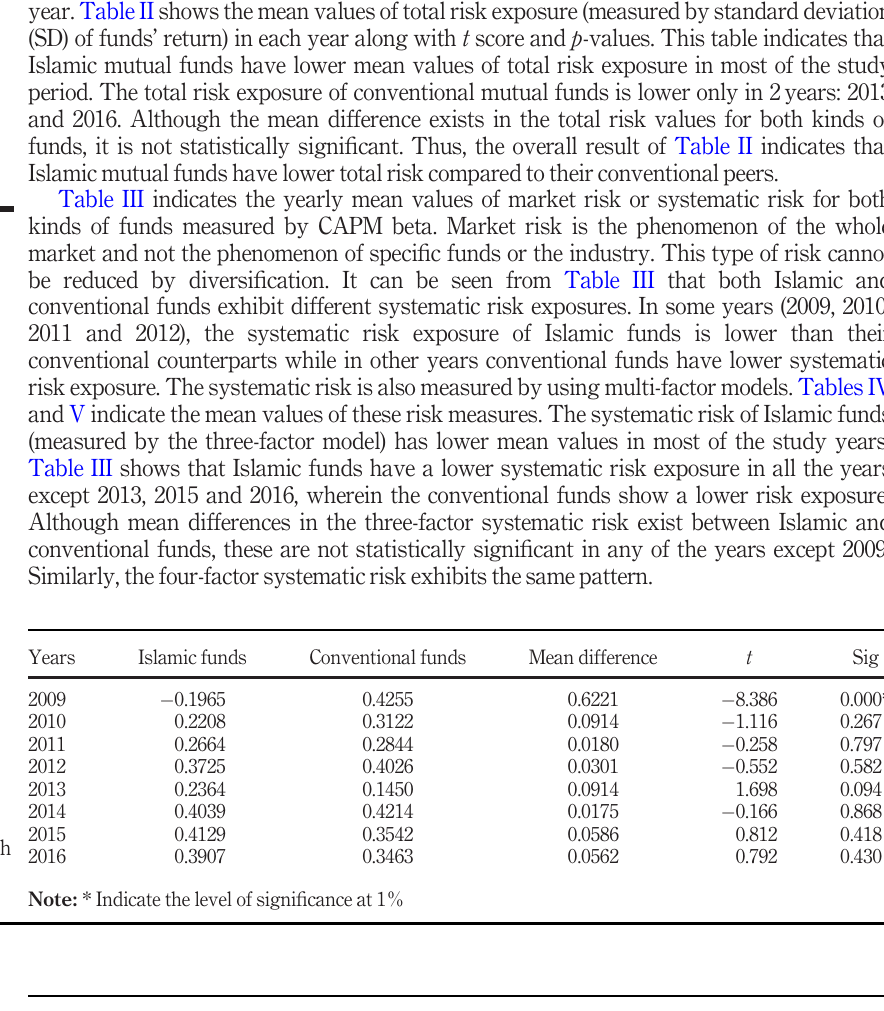
Table IV. Yearly mean values of systematic risk (three-factor beta)